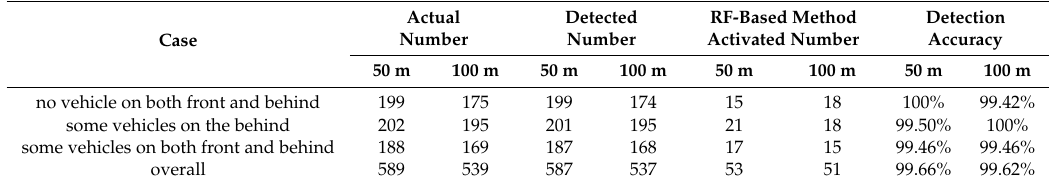
Table 2. Vehicle detection accuracy of our proposed